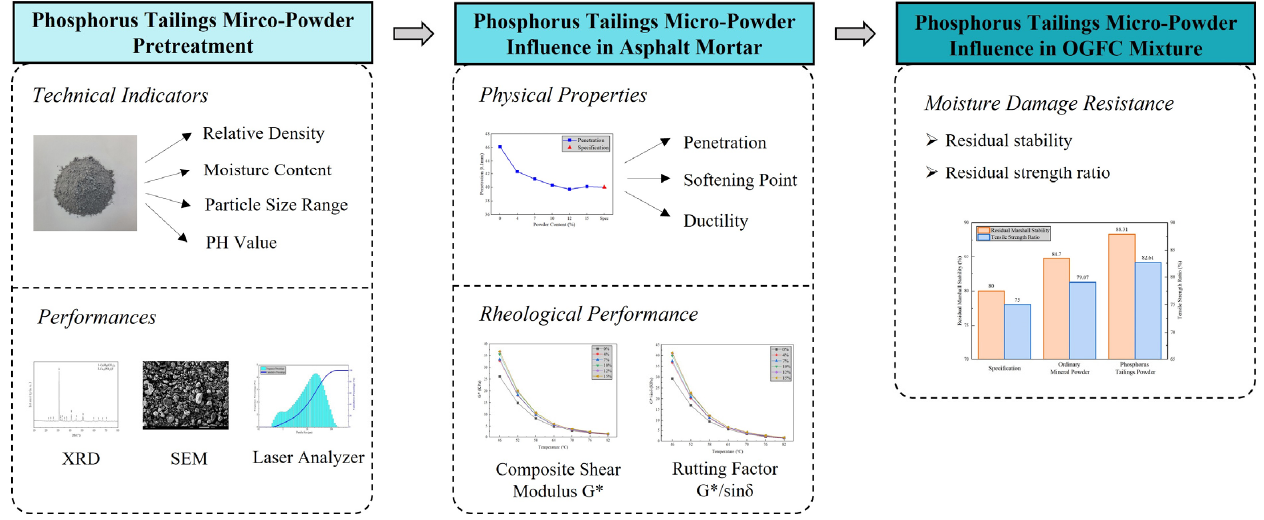
Figure 1. The research diagram of this study.